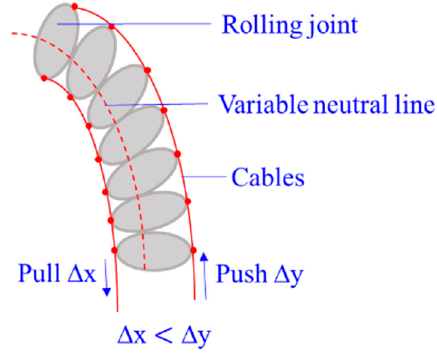
Figure 12. A rolling-joint CCR with a cable-driven system [105].